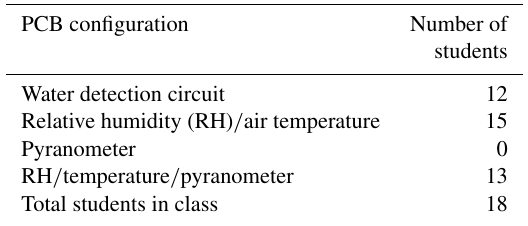
Table 2. Estimated list of defects associated with PCBs created by the